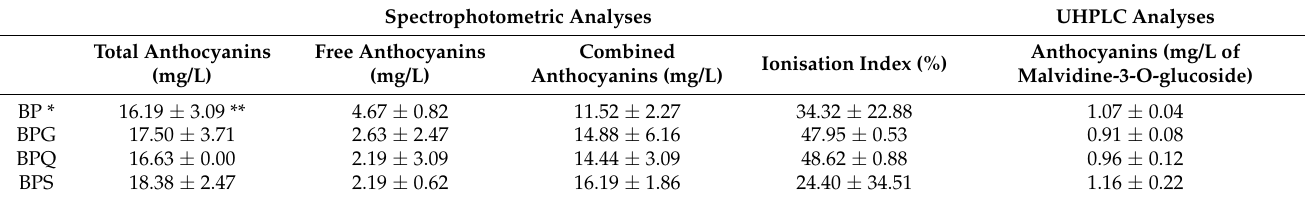
Table 3. Anthocyanins analyses by spectrophotometric and UHPLC